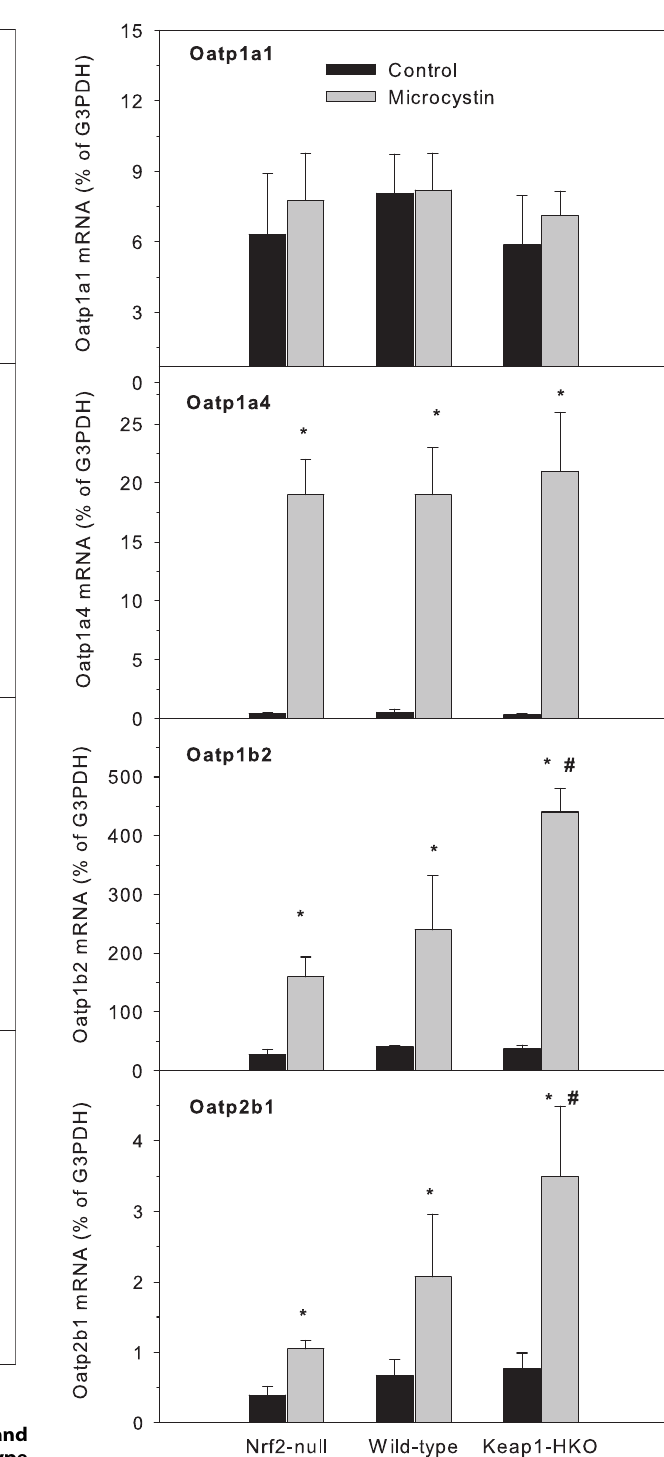
Figure 8. Expression of hepatic organic anion transporting peptide Oatp1a1, Oatp1a4, Oatp1b2, and Oatp2b1 in Nrf2- null, wild-type and Keap1-HKO mice administered saline (10 ml/kg, i.p.) or microcystin (50 m g/kg, i.p.). Livers were removed 8 h after microcystin and mRNA quantified by RT-PCR. Values are expressed as mean 6 S.E.M. (n=8). *Significantly different from the basal level of the same genotype (p # 0.05); # Significantly different from Nrf2-null mice treated with microcystin (p # 0.05).